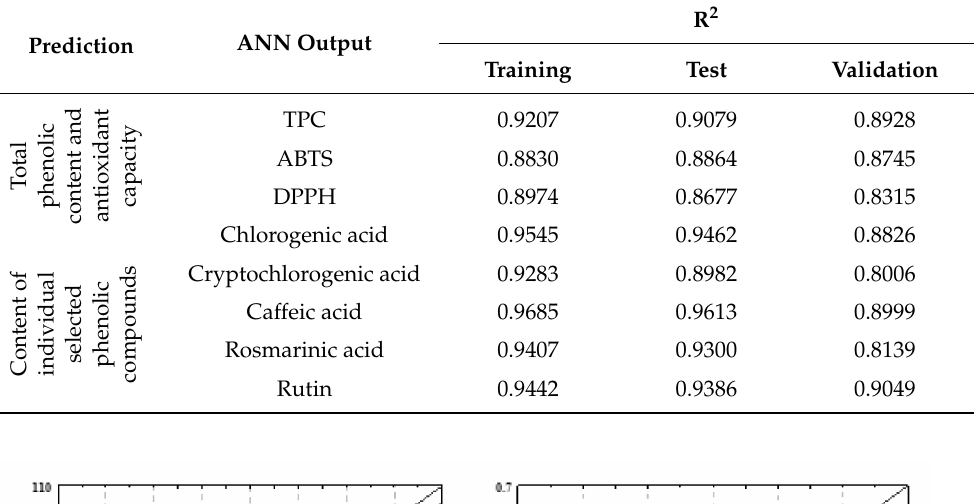
Table 5. Correlation coefficients for ANN prediction of (i) total phenolic content (TPC) and antioxidant capacity, and (ii) content of individual selected phenolic compounds in ground ivy extracts based on NIR spectra.